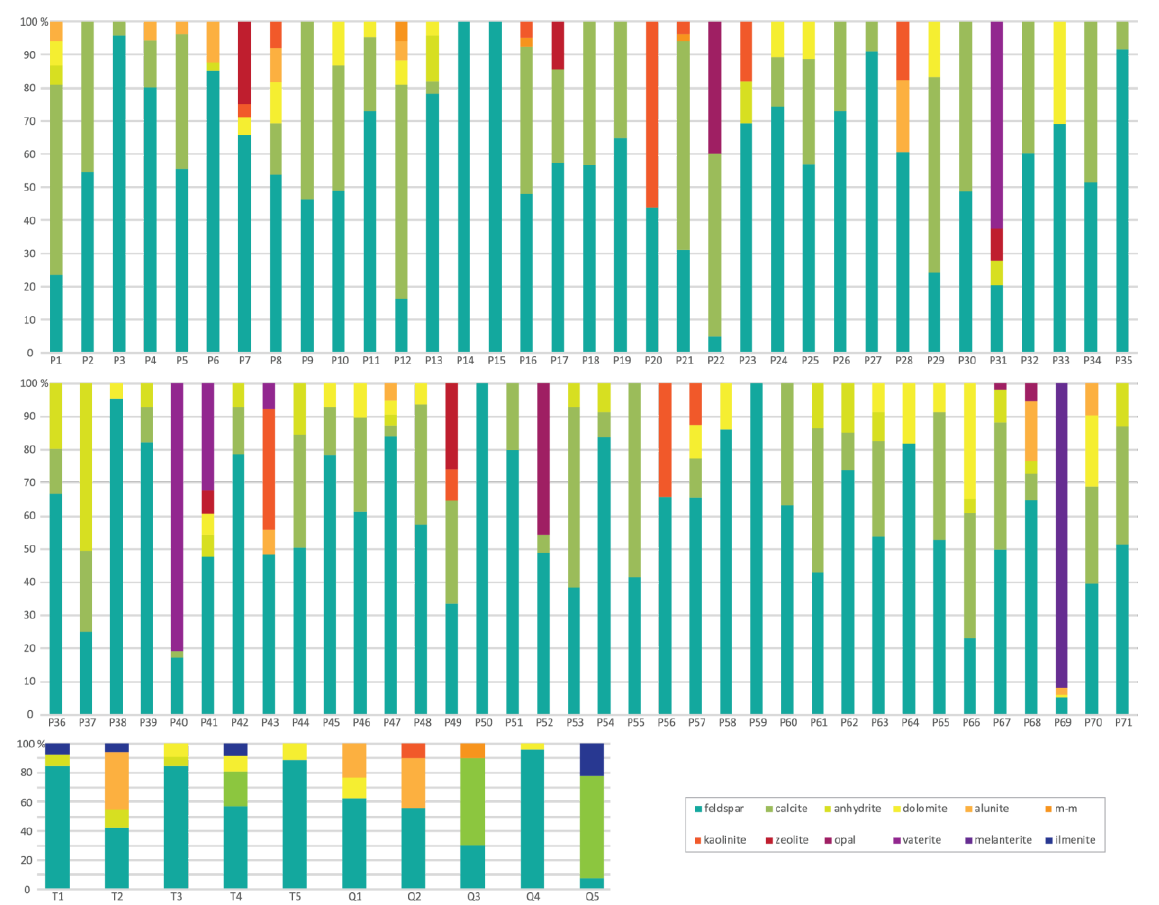
Figure 2. Mineral phases identified on the studied soils and local background samples. Quartz was not considered. Table 2. Descriptive statistics of studied soil and local background samples (in